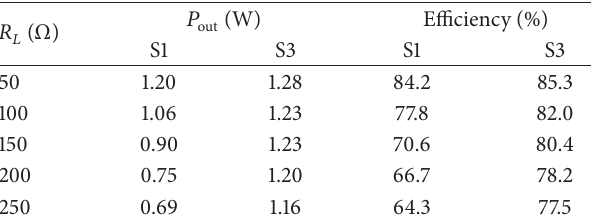
Table 6: Measured power transmission efficiencies and output powers. (The load reactance 𝑋 𝐿 is fixed at 0 Ω